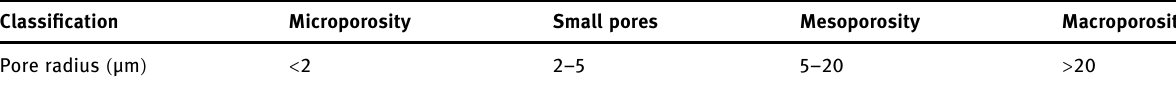
Table 6: Pore classi fi cation